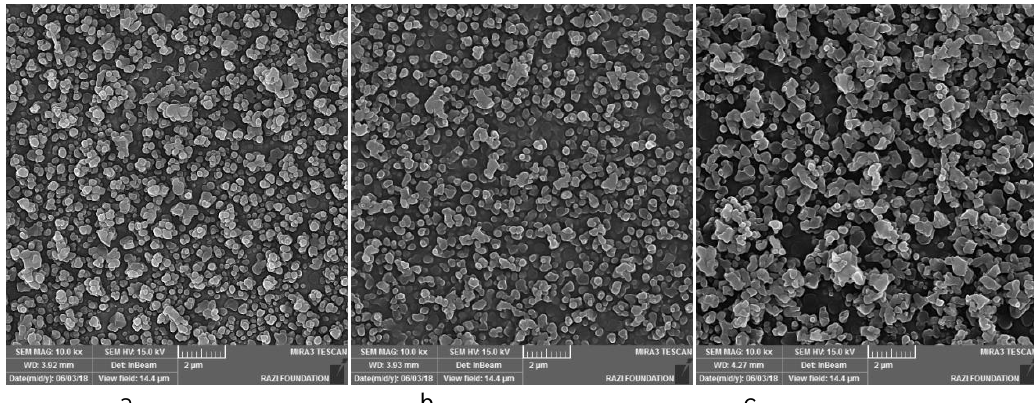
Fig .4 (a, b, c): SEM of the fractured surface of DLC thin films at the different distance between the quartz substrate and the end of the plasma torch, a- 2 cm. b-2.5 cm. c- 3